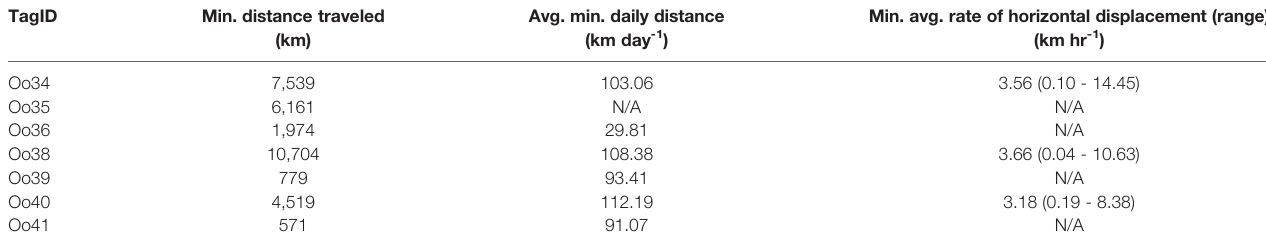
Min. distance traveled